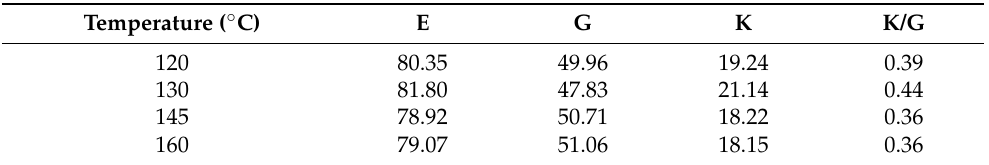
Table 3. Mechanical property parameters of Al-Zn-Mg-Cu solid solution alloy at different heat treat- ment temperatures.